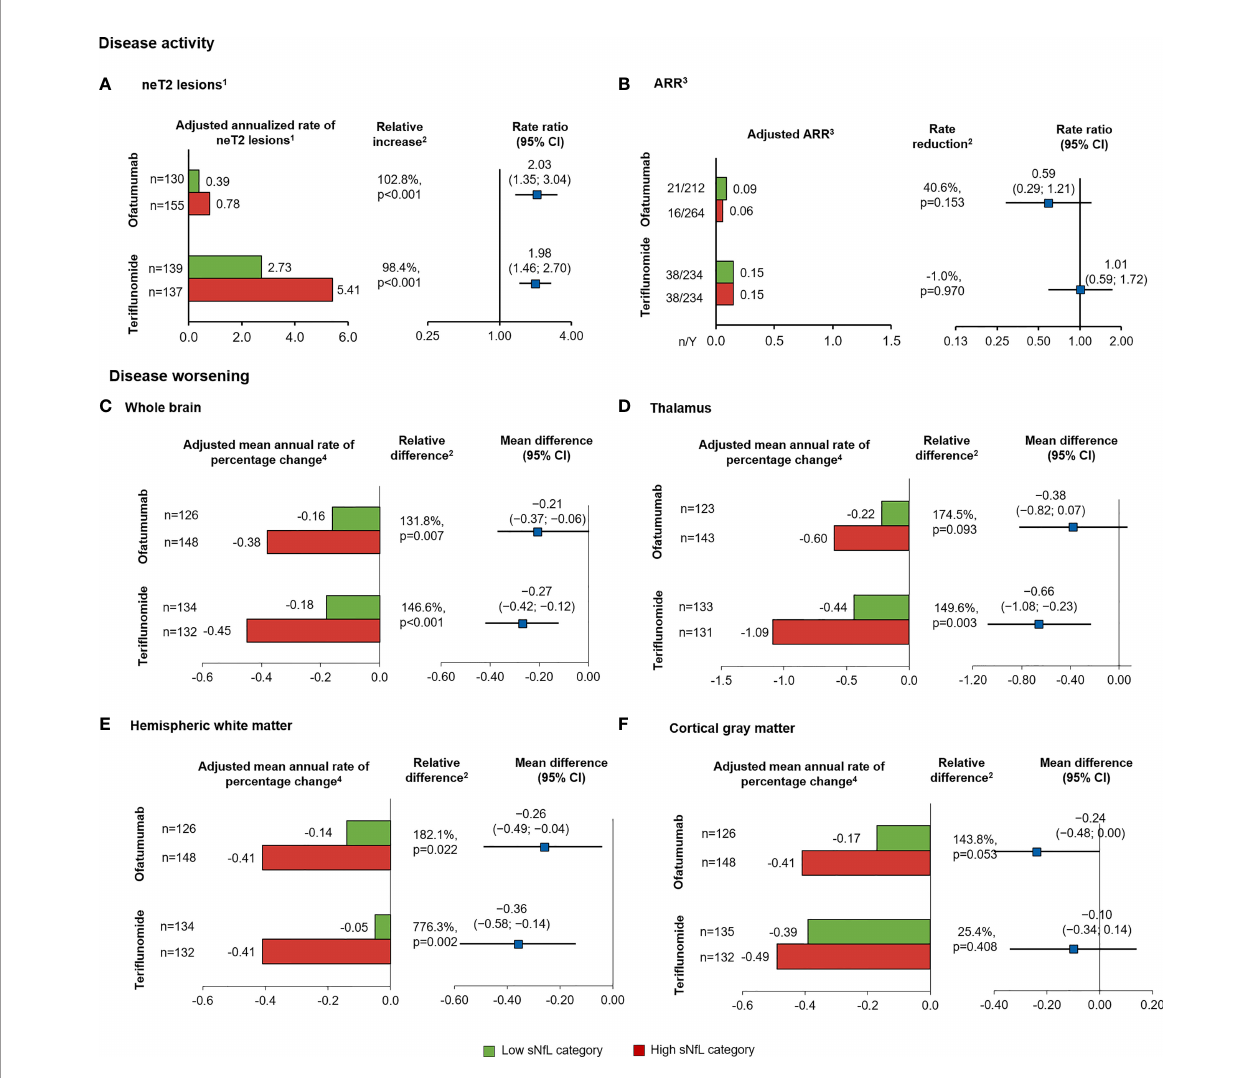
FIGURE 4 | Prognostic value of baseline sNfL category [high (red), ≥ 9.3 pg/ml; low (green), <9.3 pg/ml) on measures of MS disease activity and worsening, in the subgroup of recently diagnosed, treatment-naive patients. (A) neT2 lesions per year, (B) annualized relapse rate. Annual rate of brain volume change in the (C) whole brain, (D) thalamic volume, (E) hemispheric WM, (F) cortical gray matter. Comparisons are between high vs. low sNfL categories. 1 The number of neT2 lesions (compared to baseline or month 12) was analyzed in a negative binomial model with adjustments for treatment, baseline sNfL category, region and study as factors, and age, baseline volume of T2 lesions as continuous covariates, and treatment by baseline sNfL category interaction. The natural log of the time from the baseline scan (in years) was used as the offset. 2 Indicates statistical signi fi cance (two-sided) at the 0.05 level. 3 Negative binomial regression model with log-link to the number of relapses adjusted for treatment, baseline sNfL category, region and study as factors, number of relapses in previous year, baseline EDSS, baseline number of Gd +T1 lesions, and the patient ’ s age at baseline as covariates and treatment by baseline sNfL category interaction. The natural log of the time in study was used as offset to annualize the relapse rate. 4 Annual rate of brain volume change obtained from a random coef fi cients model with study, treatment as fi xed effects (factors), and time as continuous covariates and treatment by time interaction for the overall analysis, with additional co-factors of subgroup, treatment by subgroup, and treatment by time by subgroup interactions for the subgroup analysis. Random terms for slopes and intercept are included. ARR, annualized relapse rate; BVL, brain volume loss; CI, con fi dence interval; cGM, cortical gray matter; EDSS, Expanded Disability Status Scale score; Gd+, gadolinium-enhancing; neT2, new or enlarging T2 lesions; LS, least square; sNfL, serum neuro fi lament light; WM, white